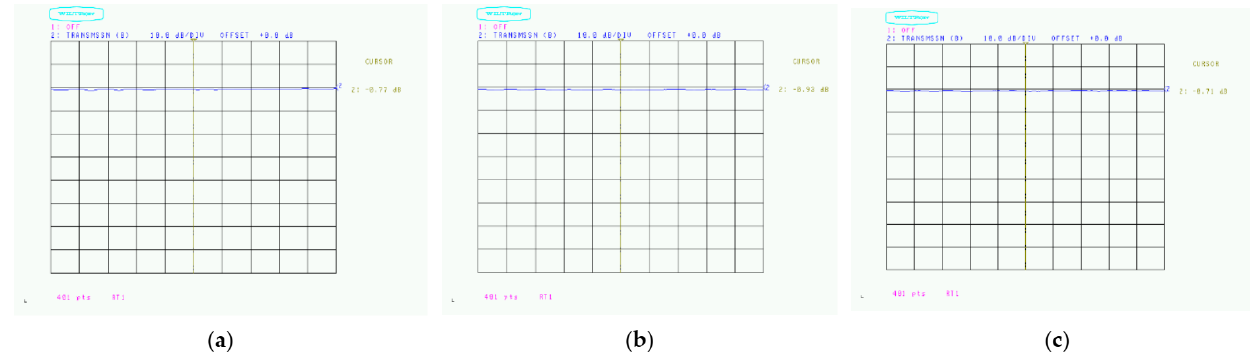
Figure 18. Radio wave absorption of graphite paint: ( a ) Coating thickness 15 µ m upper part (0.77 dB); ( b ) Coating thickness 36 µ m lower part (0.93 dB); ( c ) Coating thickness 74 µ m upper part (0.71